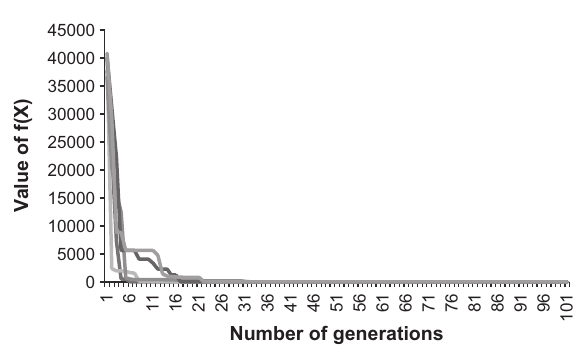
Figure 4. Variation of solution for the sphere function for modified ABC for five different runs.